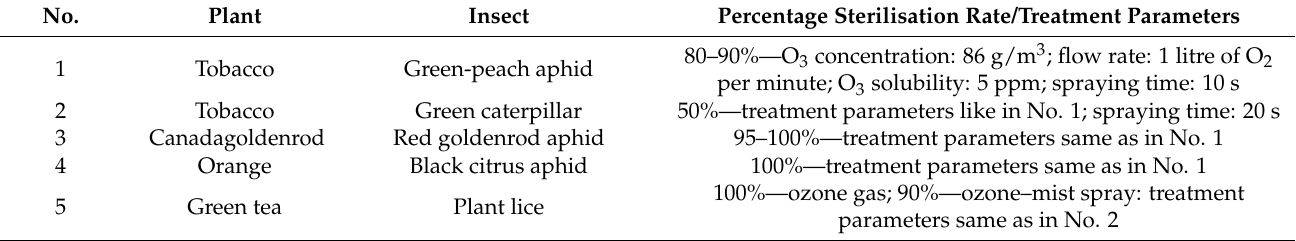
lice—on green tea. Treatment parameters for the ozone–mist spray system were the same